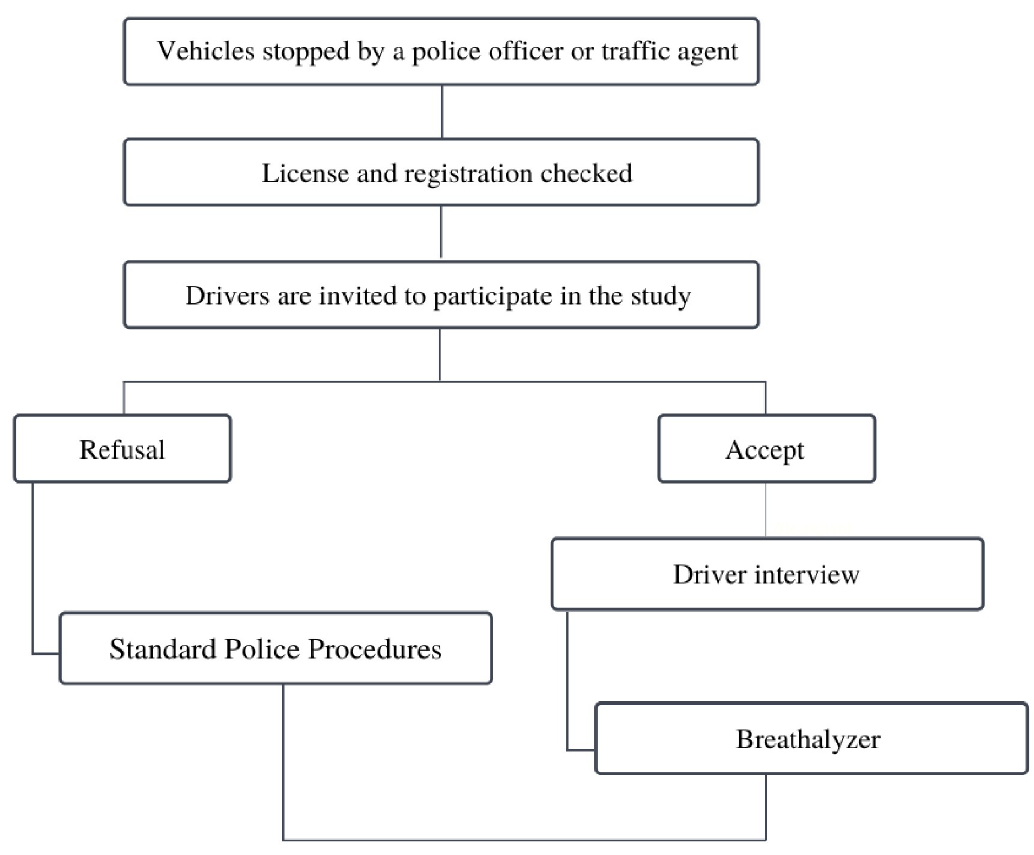
Fig 1. Study data collection flowchart,